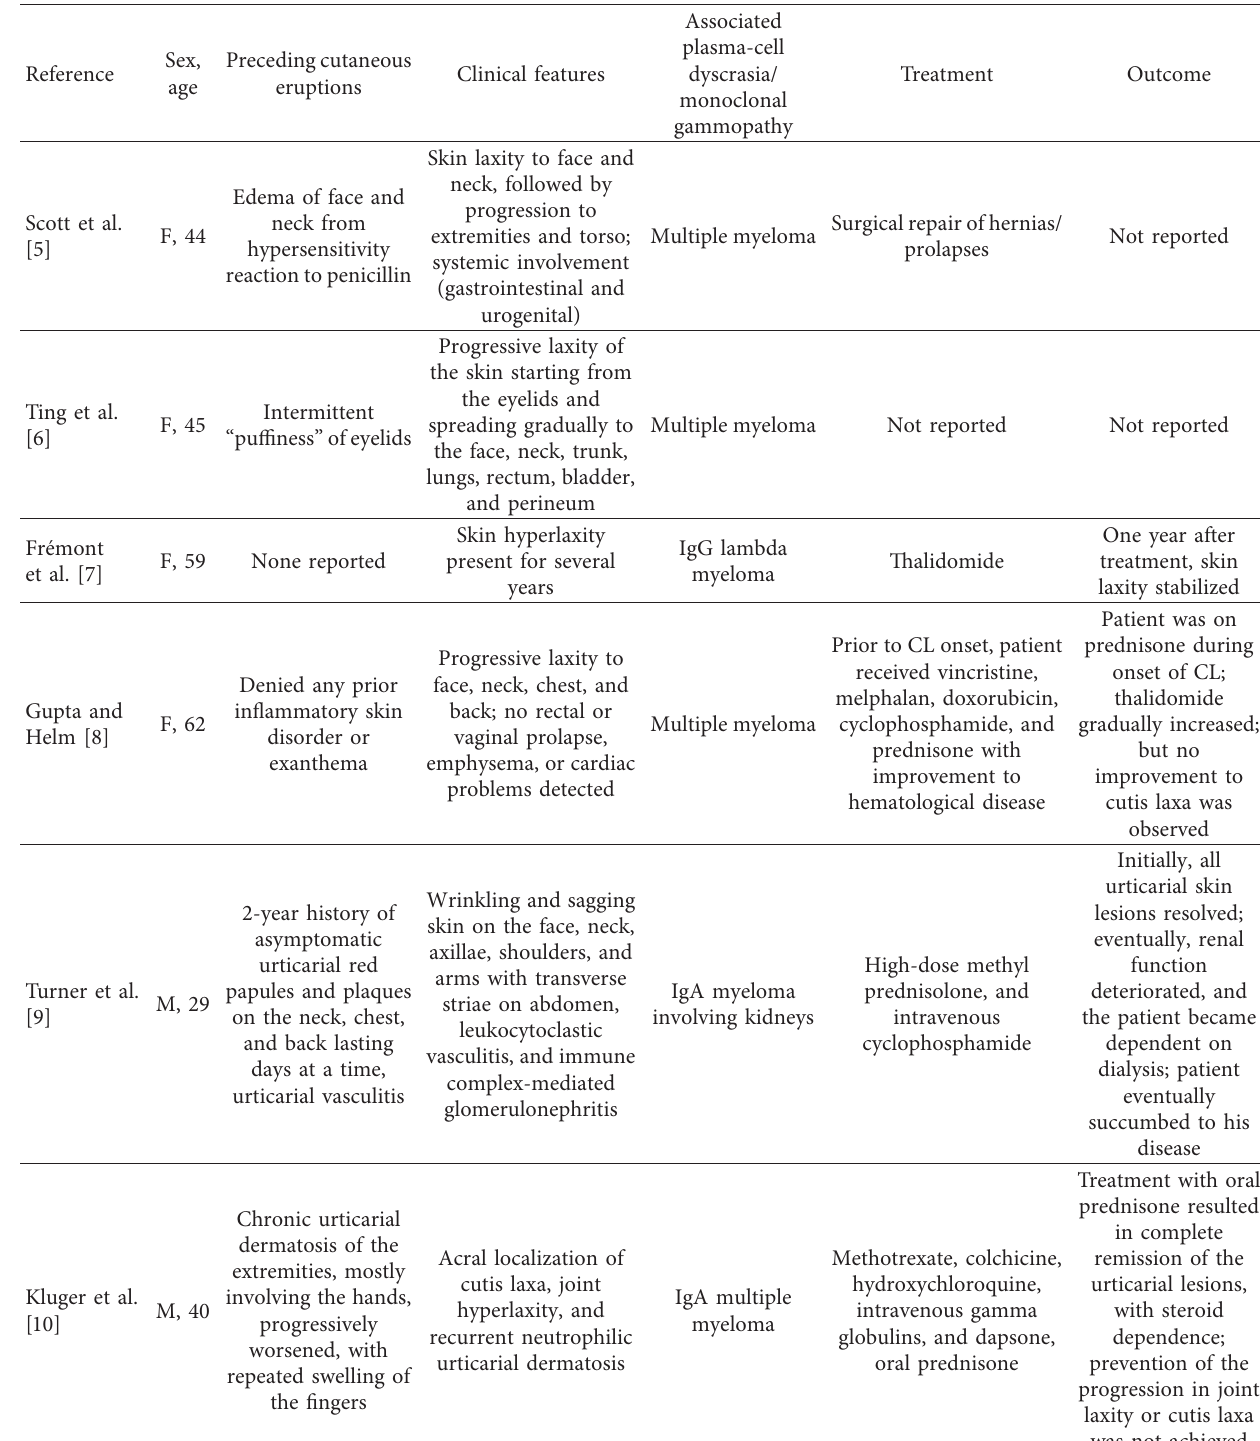
Table 1: Summary of acquired cutis laxa associated with monoclonal gammopathies/plasma-cell dyscrasia.